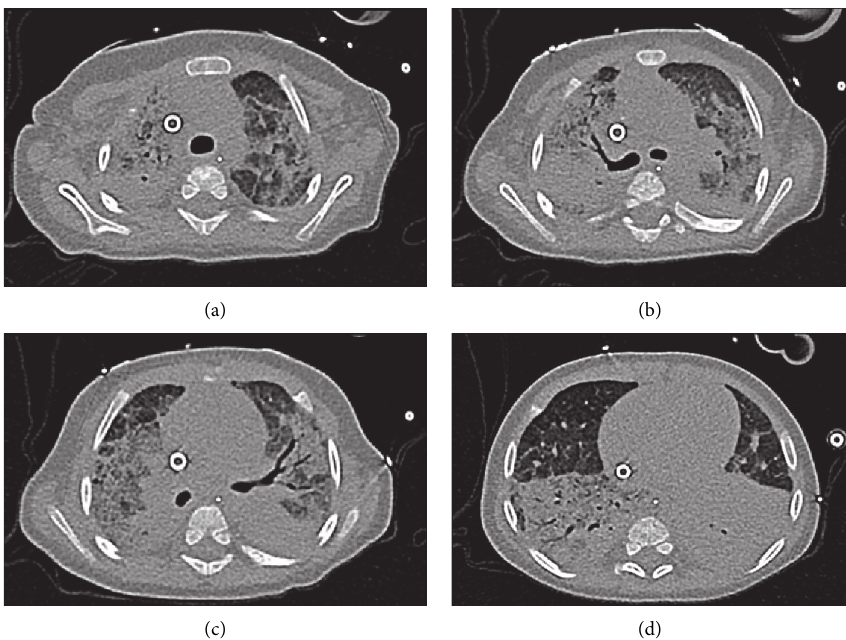
Figure 3: A thoracic computed tomograph taken during VV-ECMO-assisted recovery from Pneumocystis pneumonia-caused ARDS. (a) Apical lesions; (b) Carinal lesions associated with fibrosis and alveolar condensation; (c) lower lobe condensation (an air bronchogram); (d) lung base condensations. Note the Avalon Cannula in the vena cava in all